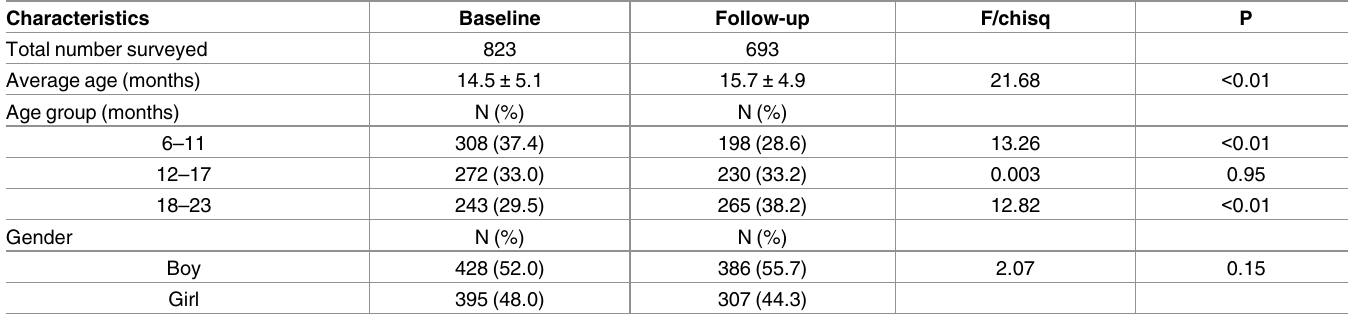
Table 1. Characteristics of the children in the baseline and follow-up surveys.